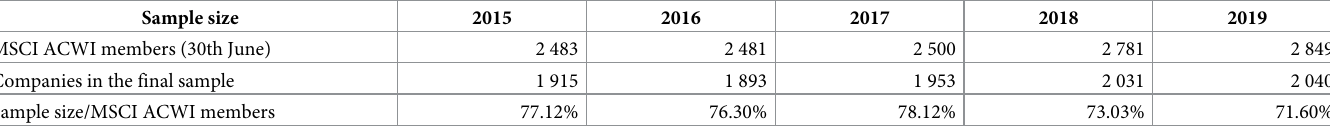
Table 3. Sample size after data cleansing and multiple imputation